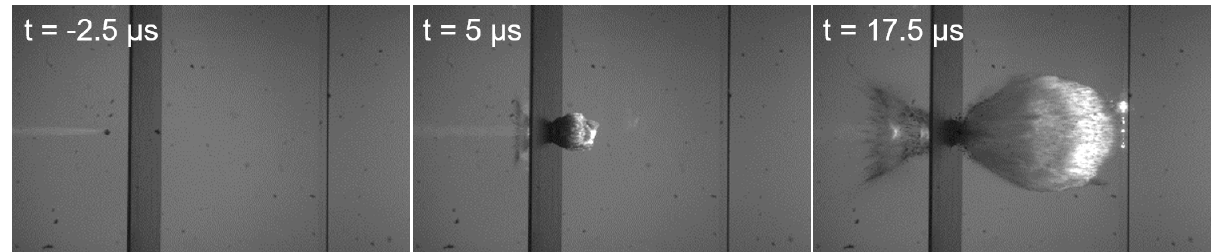
Figure 1. Hypervelocity impact experiment performed at Fraunhofer EMI’s two-stage light-gas gun facility. The spherical projectile, travleing at 6.8 km/s impacts the target plate from left to right. A cloud of debris fragments is generated and impacts the witness plate on the right.